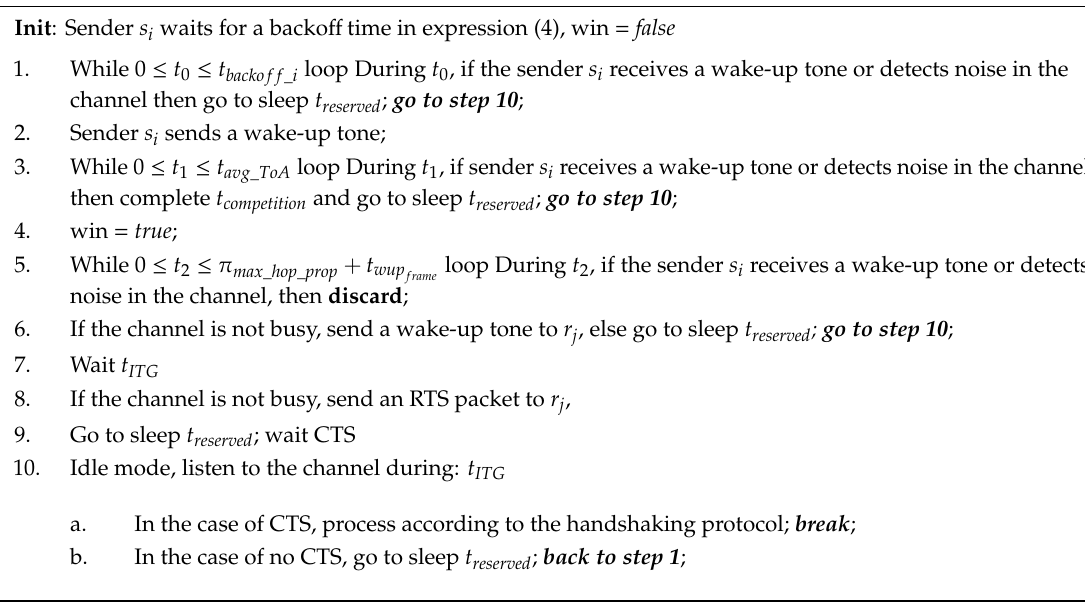
Algorithm 1. Tone-competition internal algorithm for